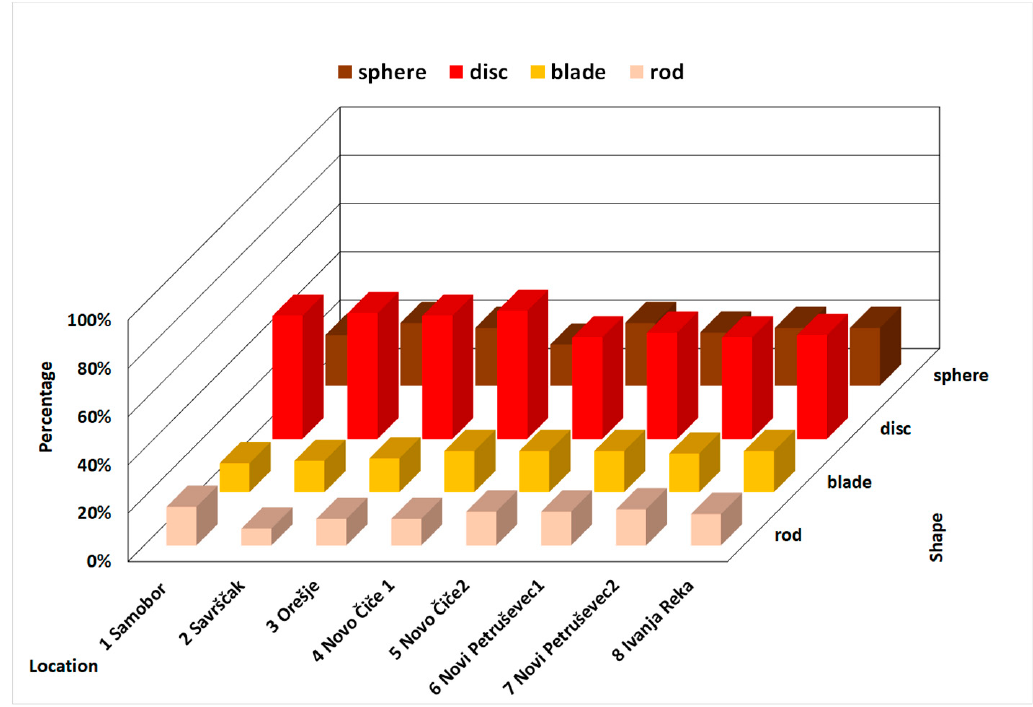
Figure 15. Distribution of pebble shapes at locations.